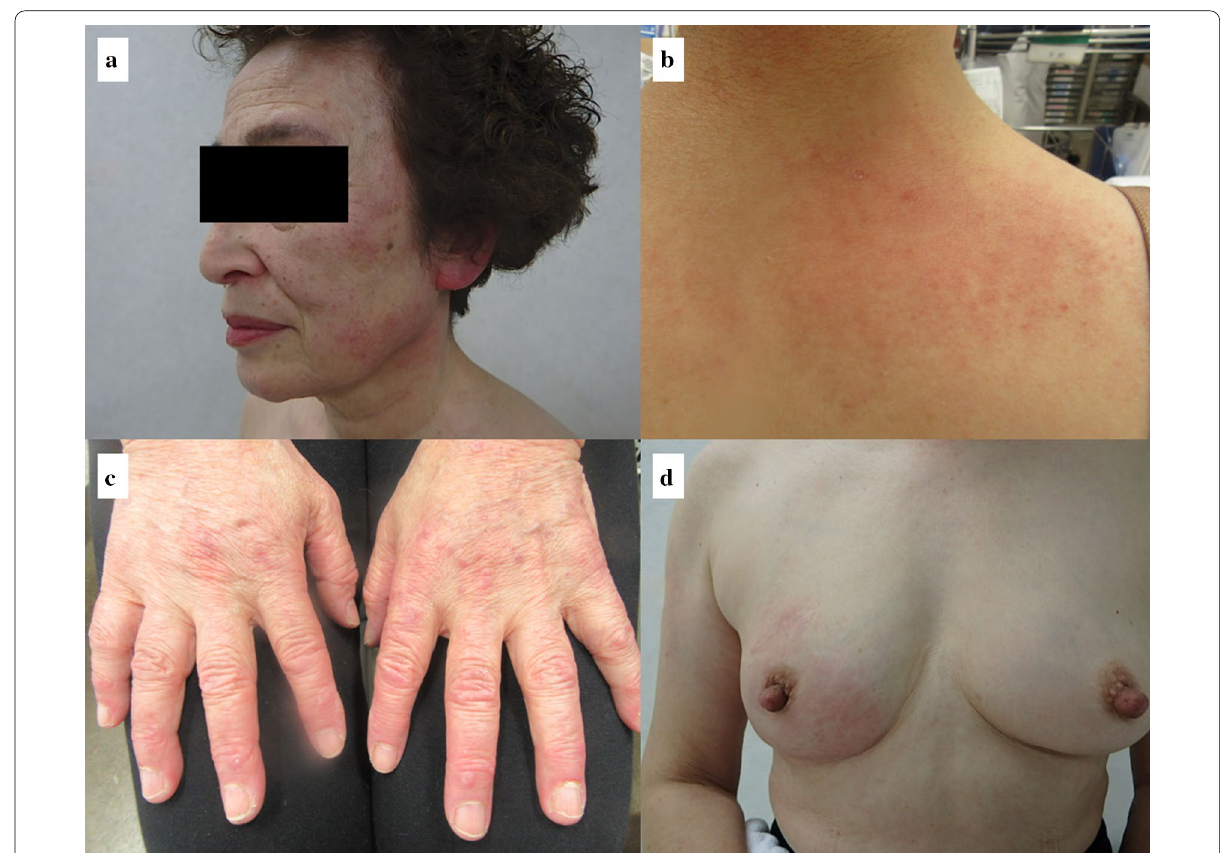
Fig. 1 a Redness was observed on the forehead, cheeks, and neck. b Redness was observed on the upper back—the ‘shawl sign’. c Multiple hyperkeratotic and erythematous papules were observed over the metacarpophalangeal and interphalangeal joints of both hands. d Redness of the skin of the right breast was observed